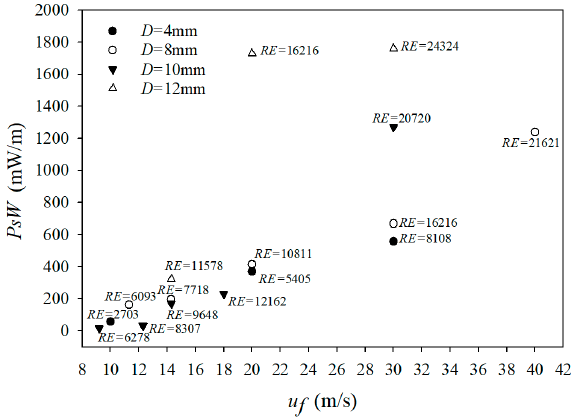
Figure 15. L = 100 mm, t p = 100 µm, Power per width evolution with the incoming fluid velocity and square cylinder diameter D . square cylinder diameter D